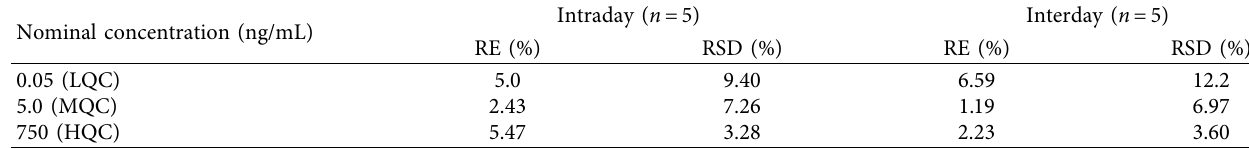
Table 4: Intraday and interday precision and accuracy for liensinine at three QC